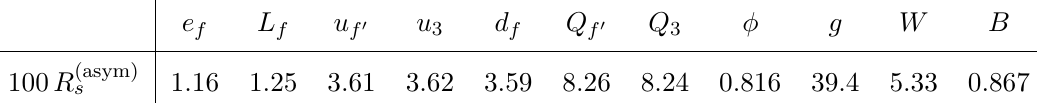
Table 1 . Asymptotic value of the fraction of distributions at a small momentum R (asym) s